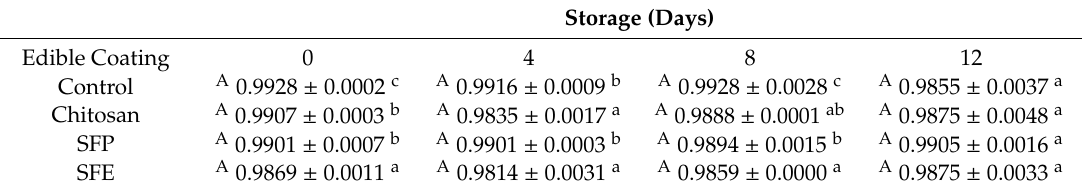
Values (mean ± standard deviation, n = 3) followed by a di ff erent uppercase letter in the same row are significantly di ff erent ( p < 0.05). Values (mean ± standard deviation, n = 3) followed by a di ff erent lowercase letter in the same column are significantly di ff erent ( p <